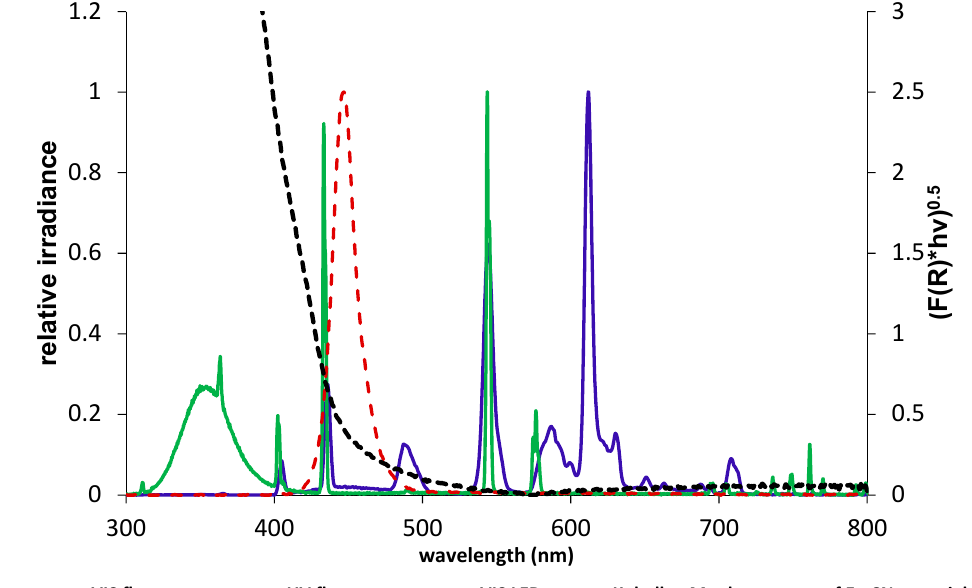
Figure 2. Emission spectra (left axis) of used light sources, UV (fluorescent), VIS (LED), VIS (fluorescent tube) and Kubelka–Munk spectrum of Ex-CN material (right axis).